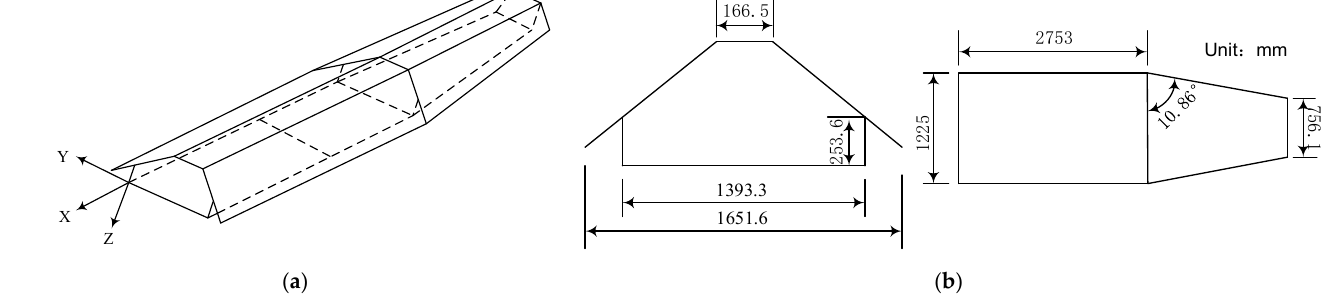
Figure 5. Simplified satellite parameters. ( a ) Simplified shape model of Swarm-C satellite; ( b ) schematic diagram of the side panel and bottom panel of Swarm-C satellite.